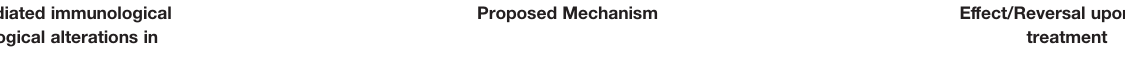
TABLE 1 | Impact of HCV on HIV disease progression. HCV-mediated immunological and virological alterations in PLWH Compromised restoration of CD4 + T cell frequency during ART